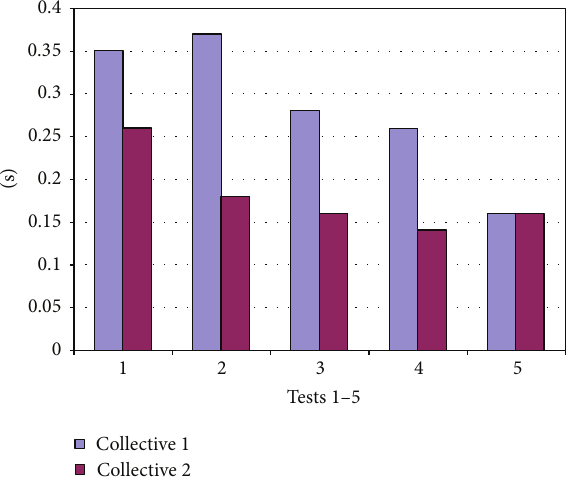
Figure 3: Standard deviation in seconds in test 1 before training and in tests 2 to 5 after training in collective 1 and 2.